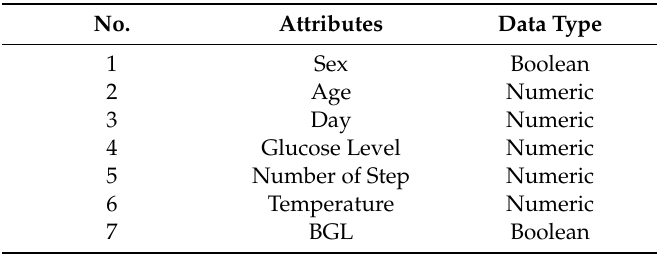
Table 4. Glucose